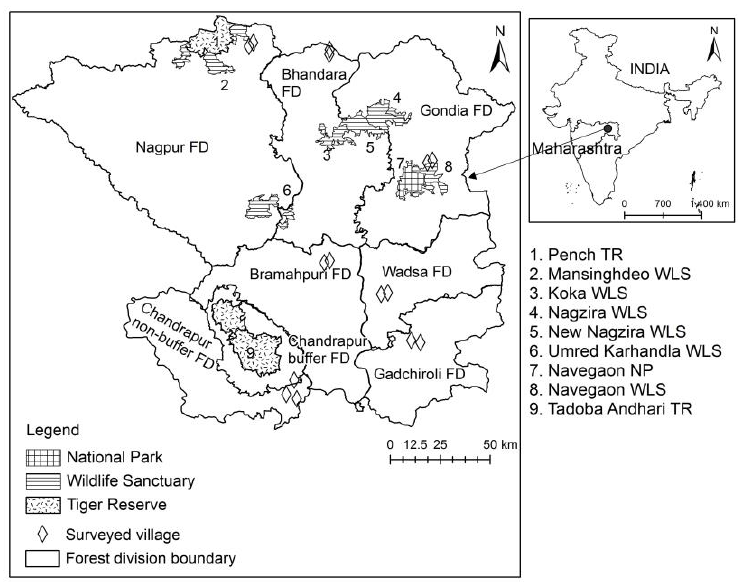
Figure 1. Study area depicting the distribution of protected areas in the study area, and the locations of 15 surveyed villages.